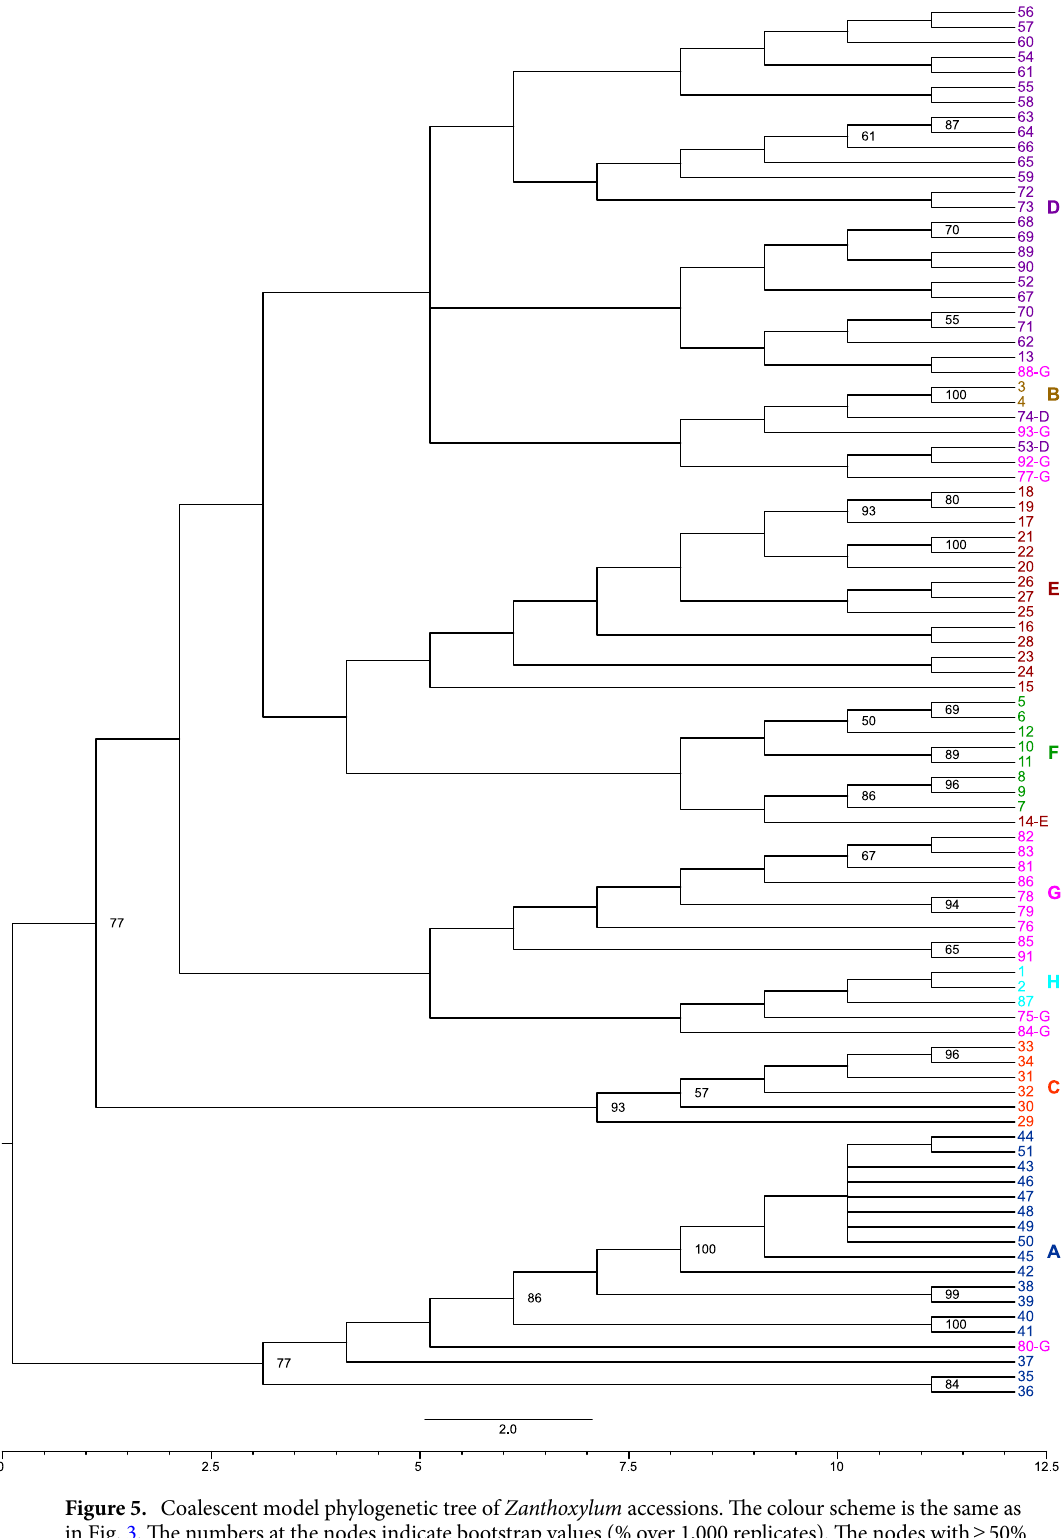
Figure 5. Coalescent model phylogenetic tree of Zanthoxylum accessions. The colour scheme is the same as in Fig. 3. The numbers at the nodes indicate bootstrap values (% over 1,000 replicates). The nodes with ≥ 50% bootstrap value are labeled. Figure was generated using FigTree (version 1.4.4, http:// tree. bio. ed. ac.